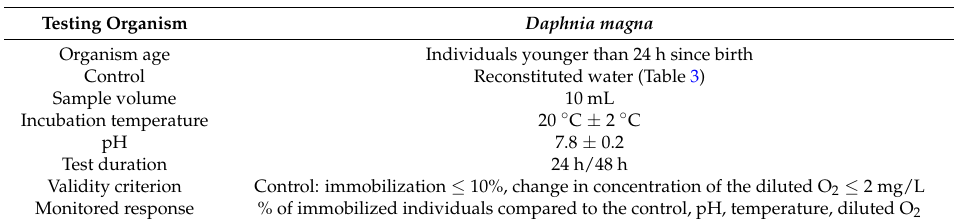
Table 4. Acute toxicity test conditions for Daphnia magna .